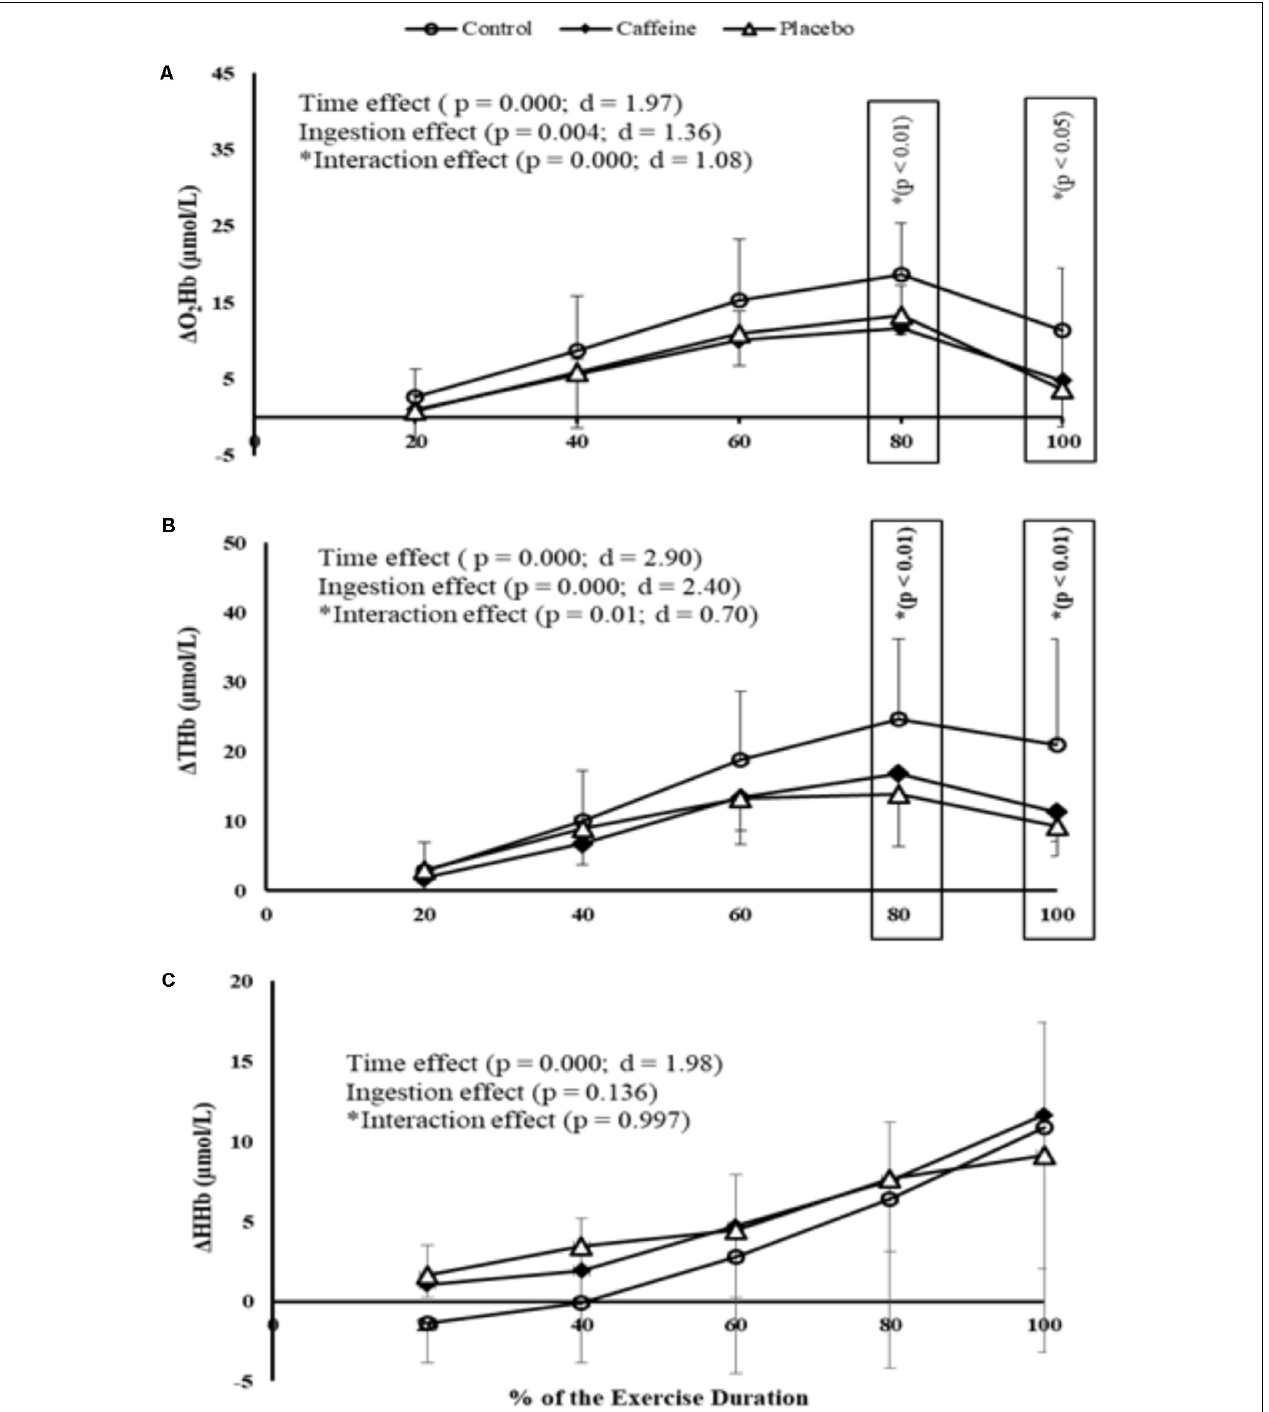
FIGURE 2 | O 2 Hb (A) , THb (B) , and HHb (C) concentrations measured at prefrontal cortex (PFC) during MIT in control, caffeine and placebo (perceived as caffeine). Main effects of time and ingestion and time by ingestion interaction effects were reported in the figure. Values are mean ( ± SD).